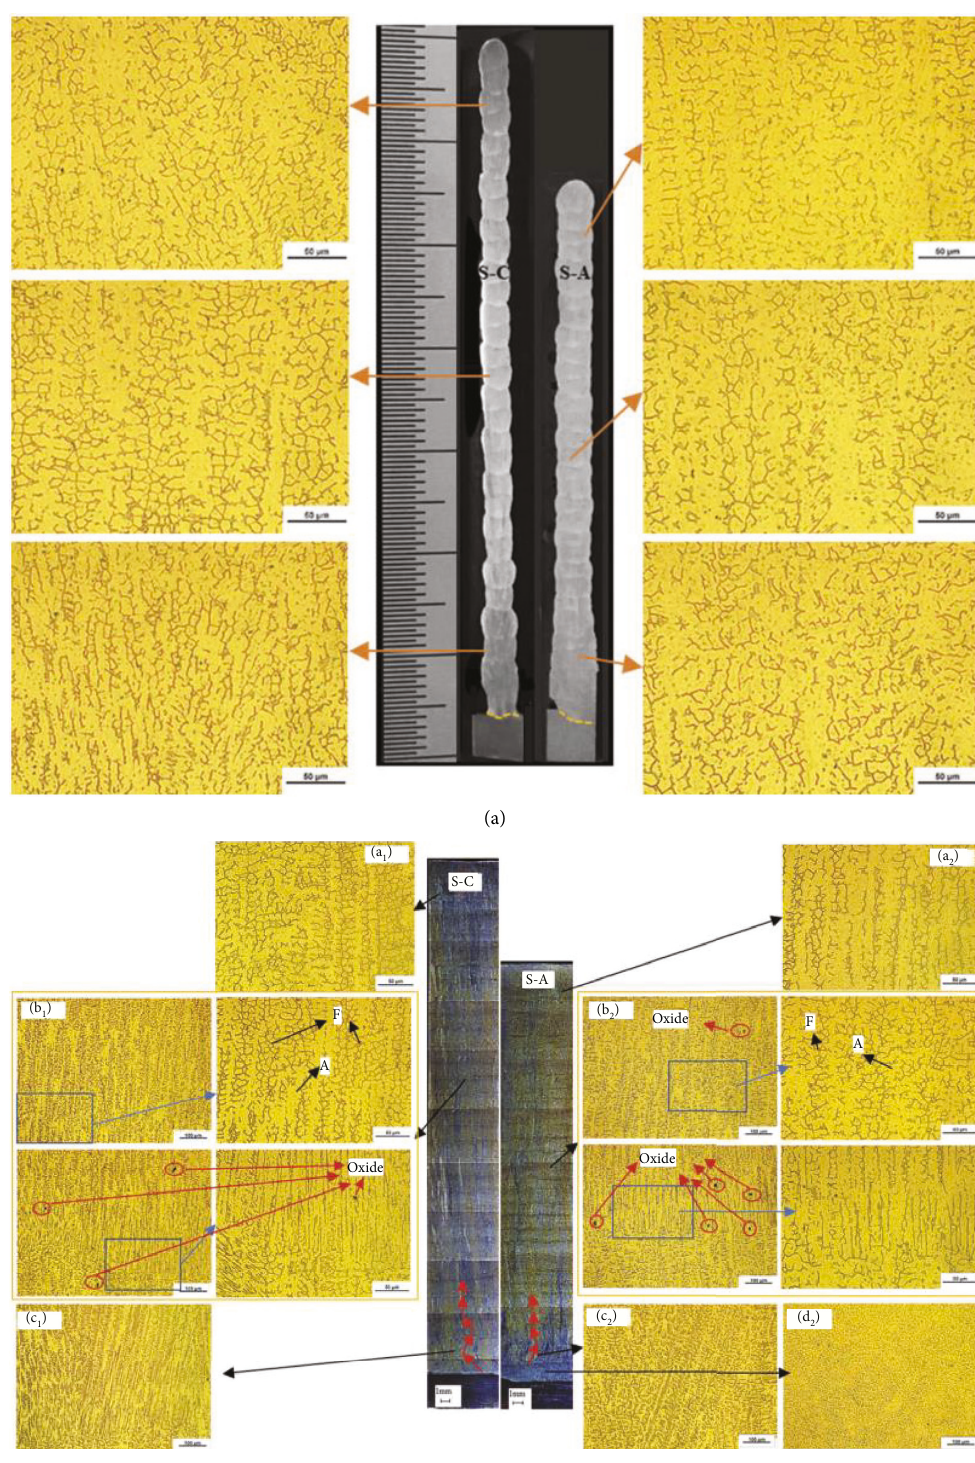
Figure 5: (a) Macrographs and microstructures of transverse cross section of samples S-C and S-A. (b) Micrographs of longitudinal section of samples S-C and S-A: (a) micrographs of the upper part on two samples; (b) micrographs of the middle part on two samples; (c) micrographs of the bottom part on two samples. (d) Micrograph of the first layer of sample